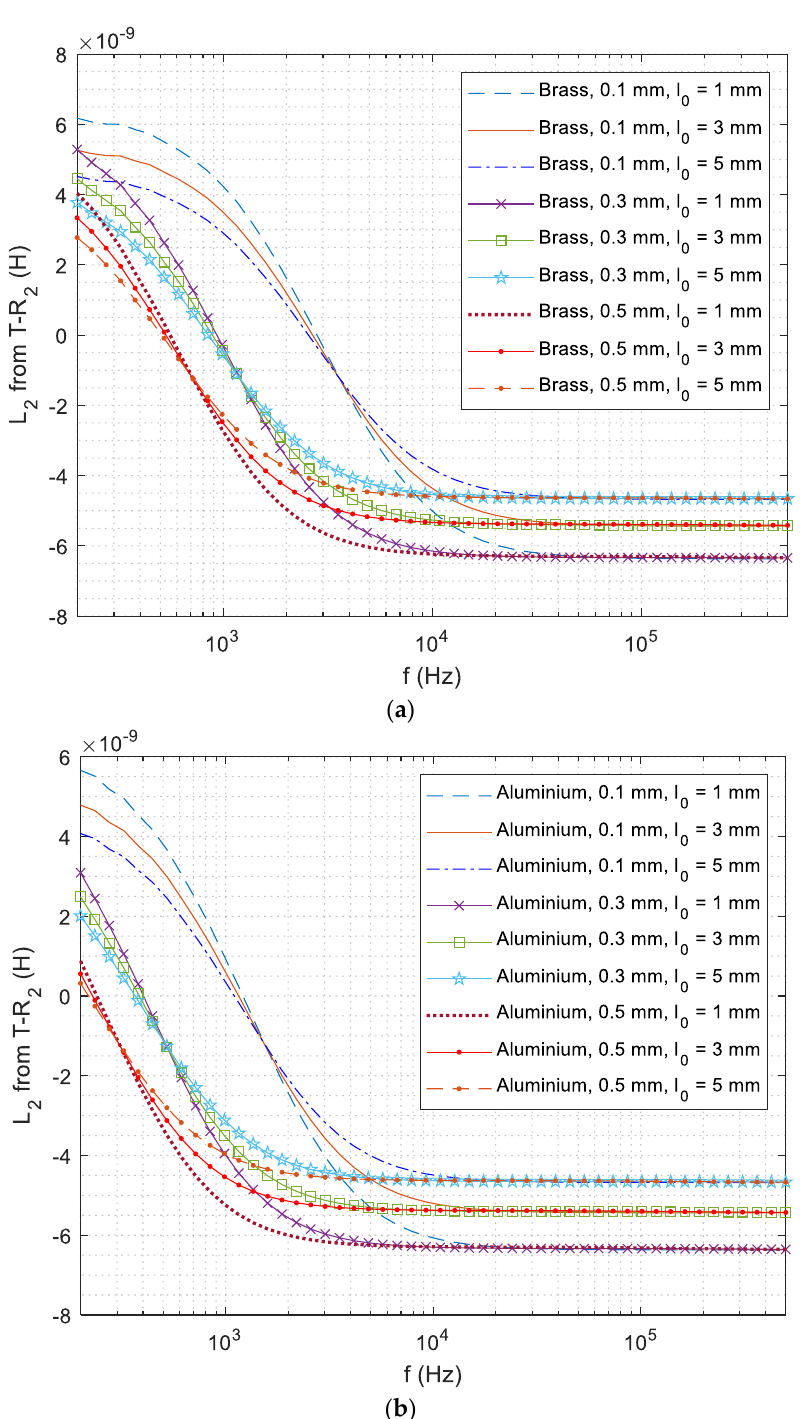
Figure 5. Experimental swept-frequency inductance curves of different lift-off distances for T − R 2 above the conductive coating (on DP 1000 steel) with different thicknesses: ( a ) brass and ( b ) alu- minium.